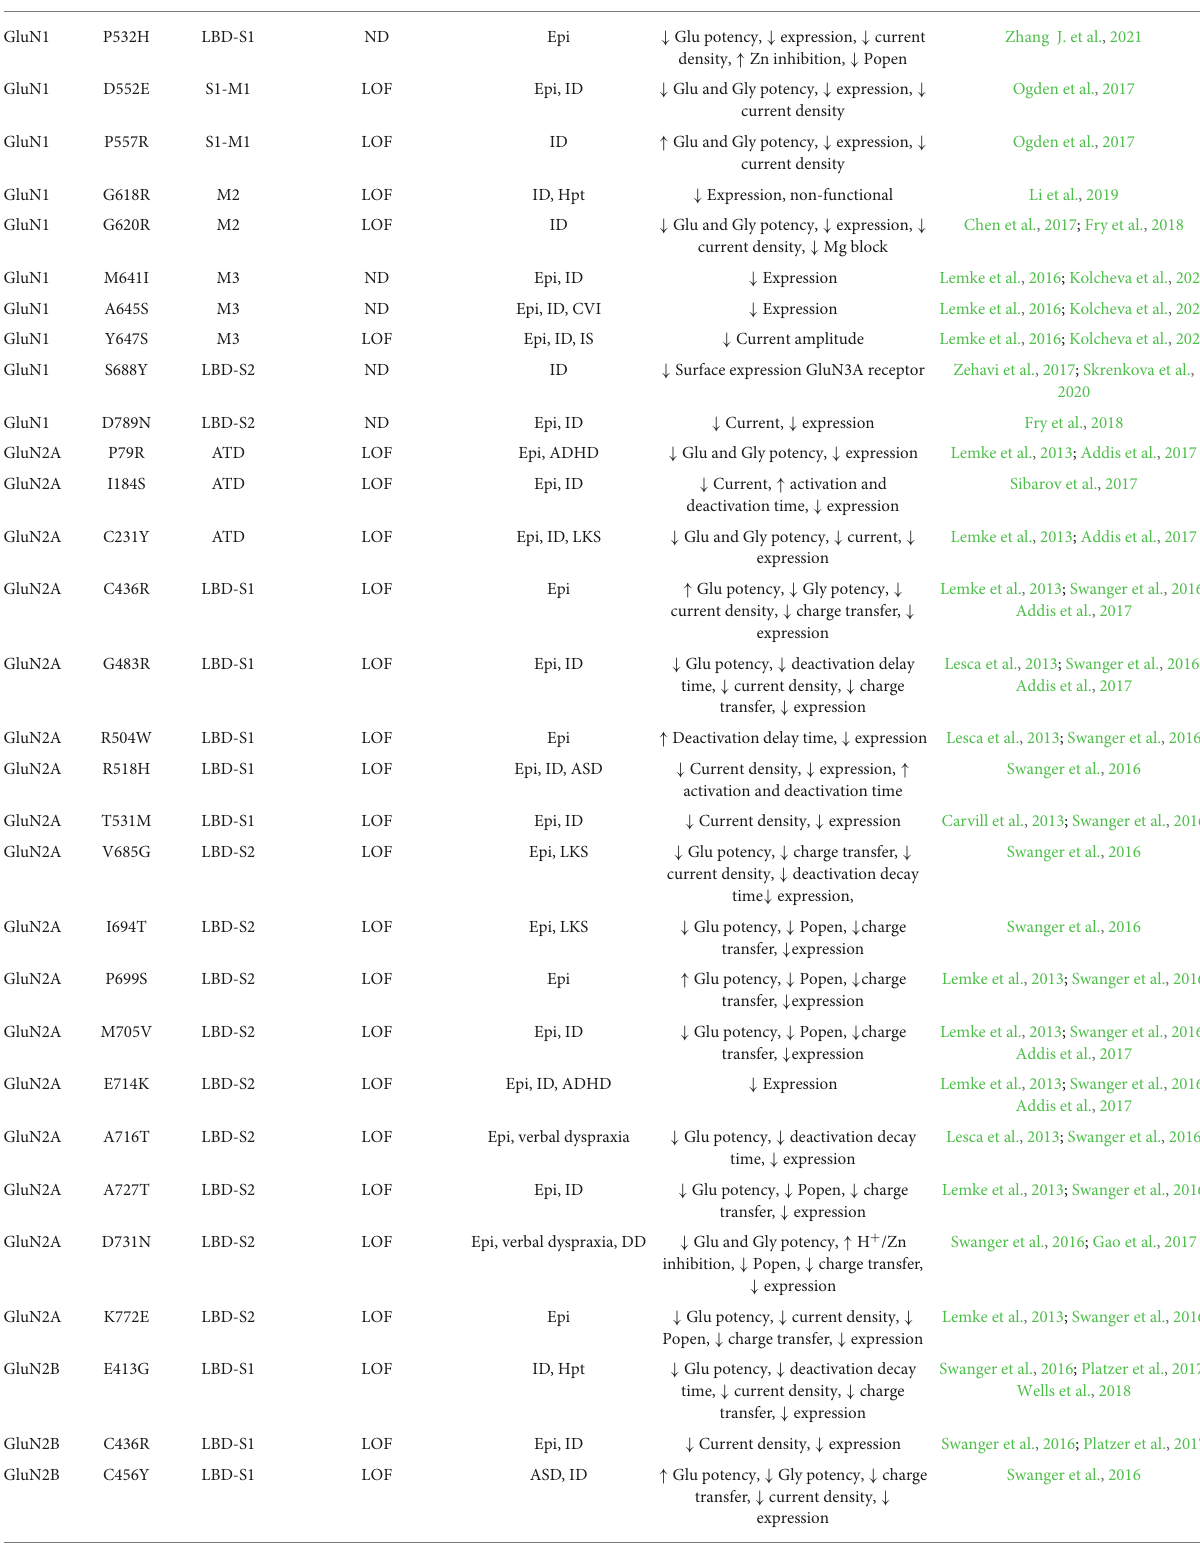
TABLE 1 Disease-associated variants with reduced surface expression* within GluN1, GluN2A, and GluN2B subunits. Subunit Variant Subdomain Functional defect Disease phenotype Functional